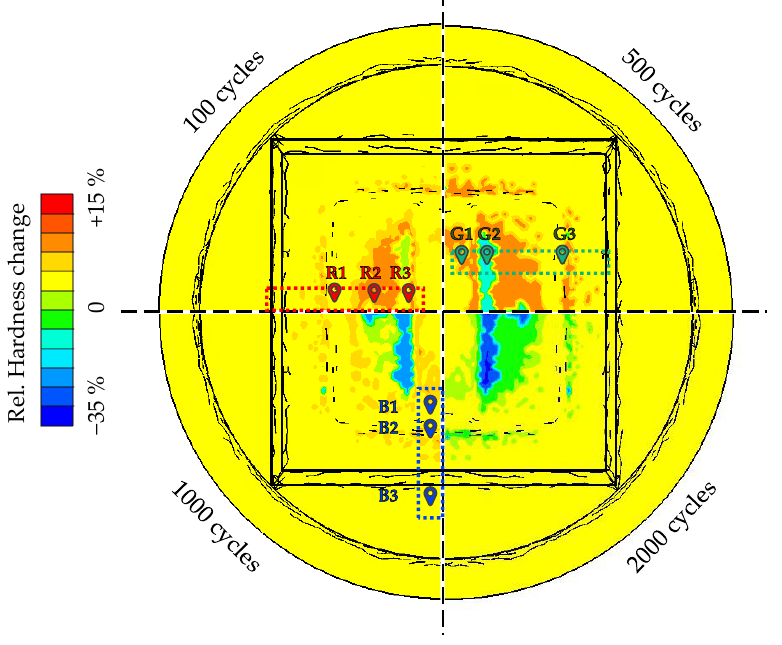
Figure 17. Numerical results of the hardness prediction and overview of the experimental validation